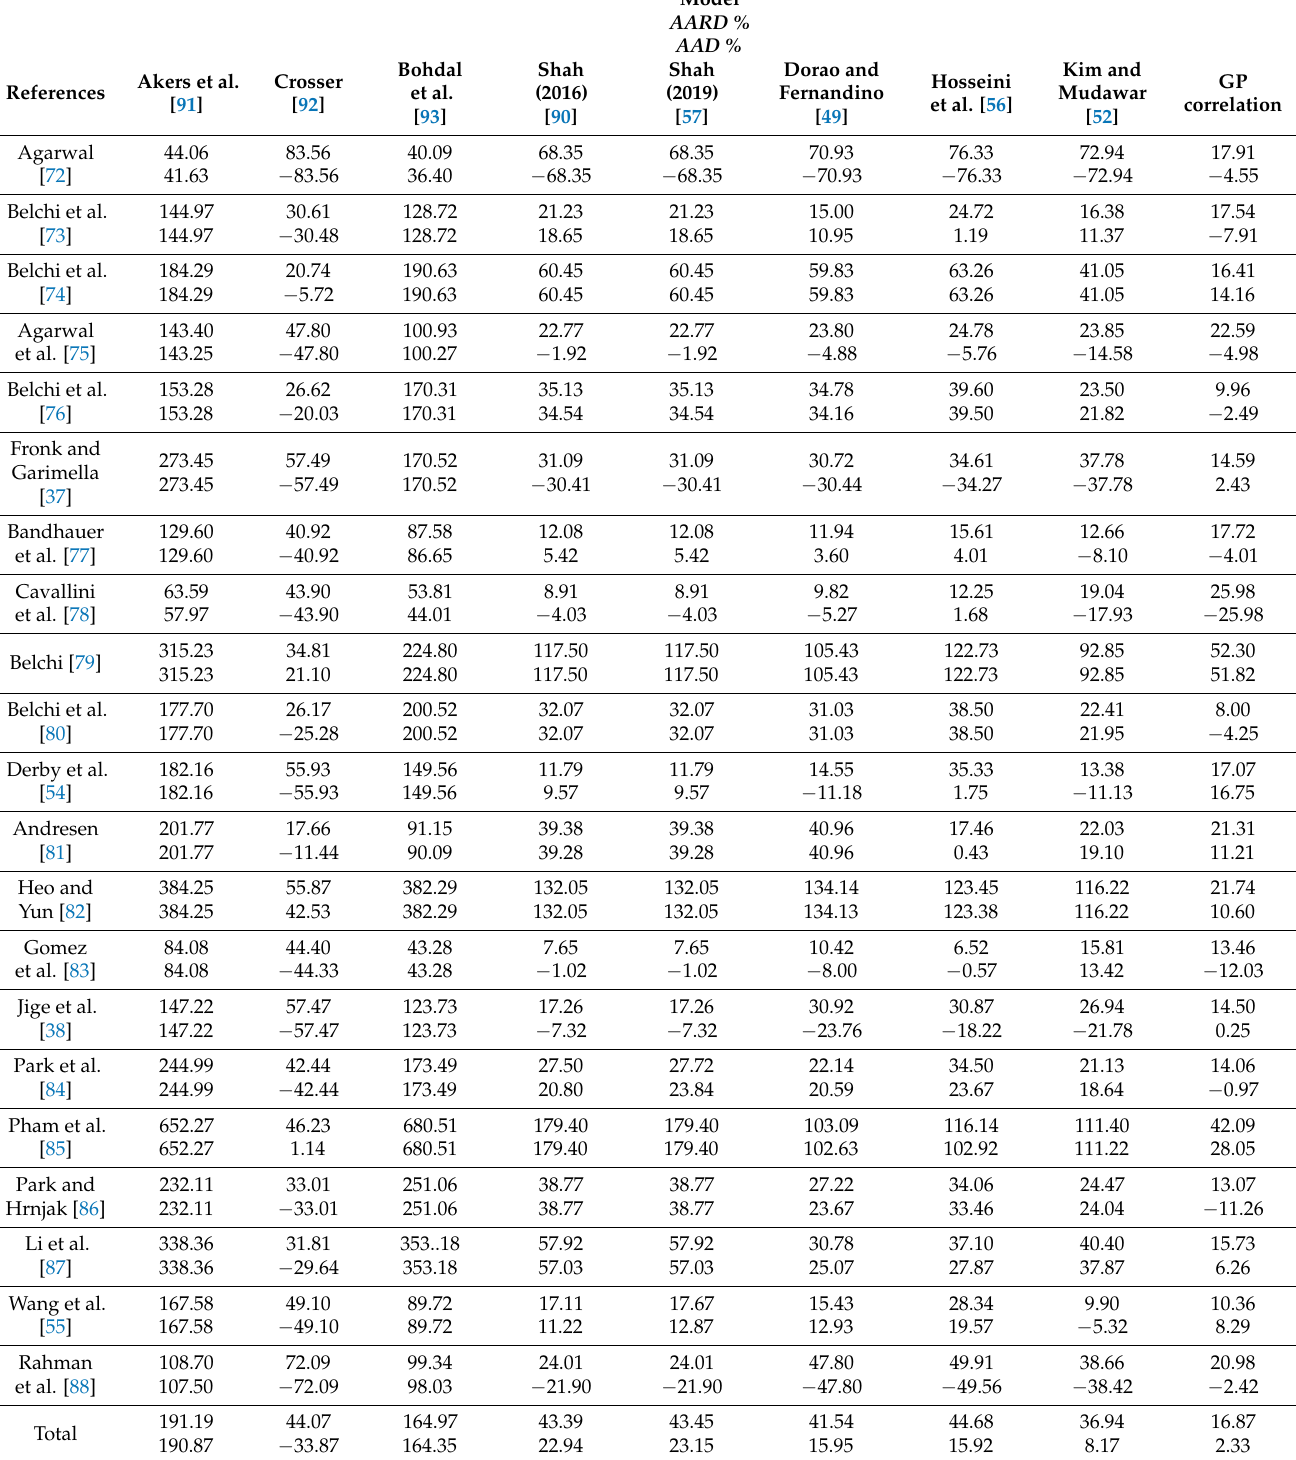
Table 4. AARD and AAD analysis of different correlations for various data sources.